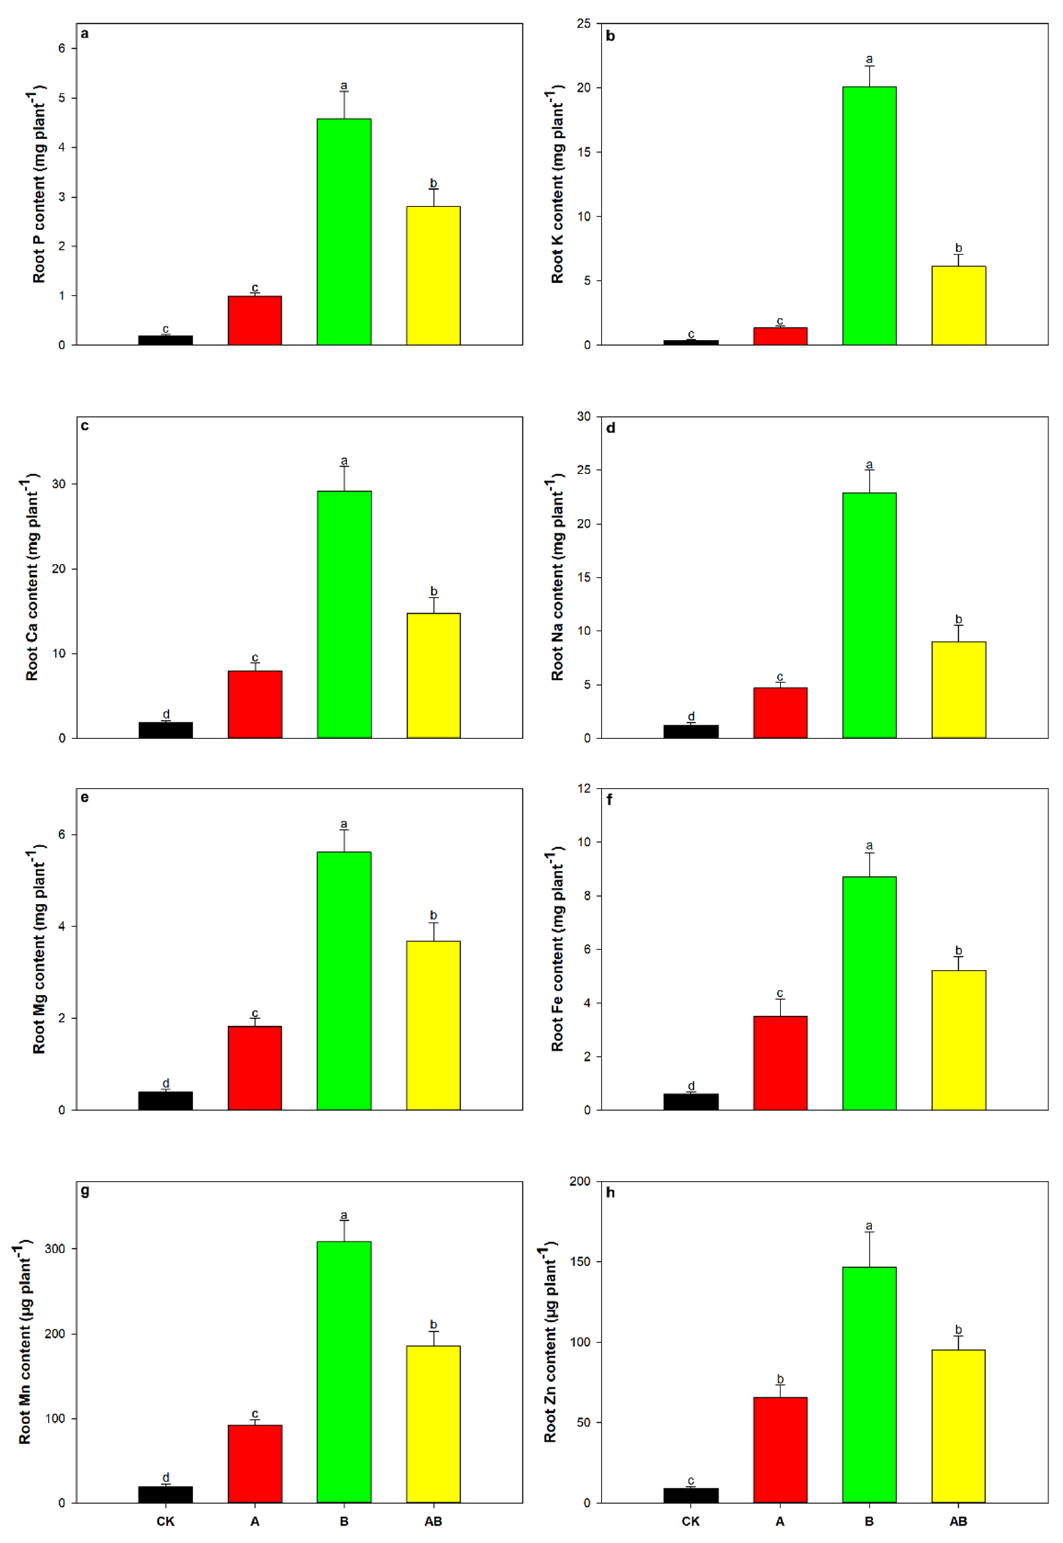
Figure 5. Effects of AMFs and biochar on root ( a ) P, ( b ) K, ( c ) Ca, ( d ) Na, ( e ) Mg, ( f ) Fe, ( g ) Mn, and ( h ) Zn contents. Data are means of five replicates ± SEs. Different letters above the columns indicate significant differences according to Duncan’s test at p < 0.05. CK, control; A, arbuscular mycorrhizal fungi; B, biochar; AB, arbuscular mycorrhizal fungi and biochar.